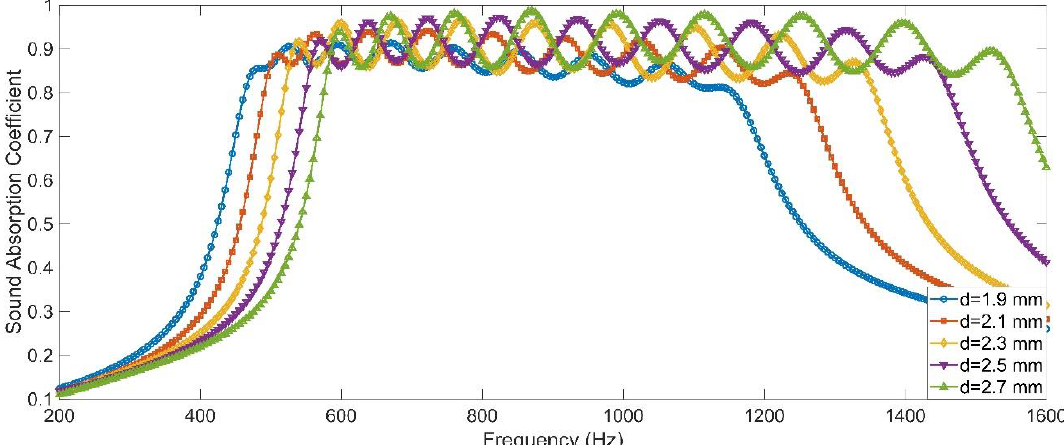
Figure 15. The sound absorption performance of the APH-AM with variable diameter of the aperture gained in simulation.